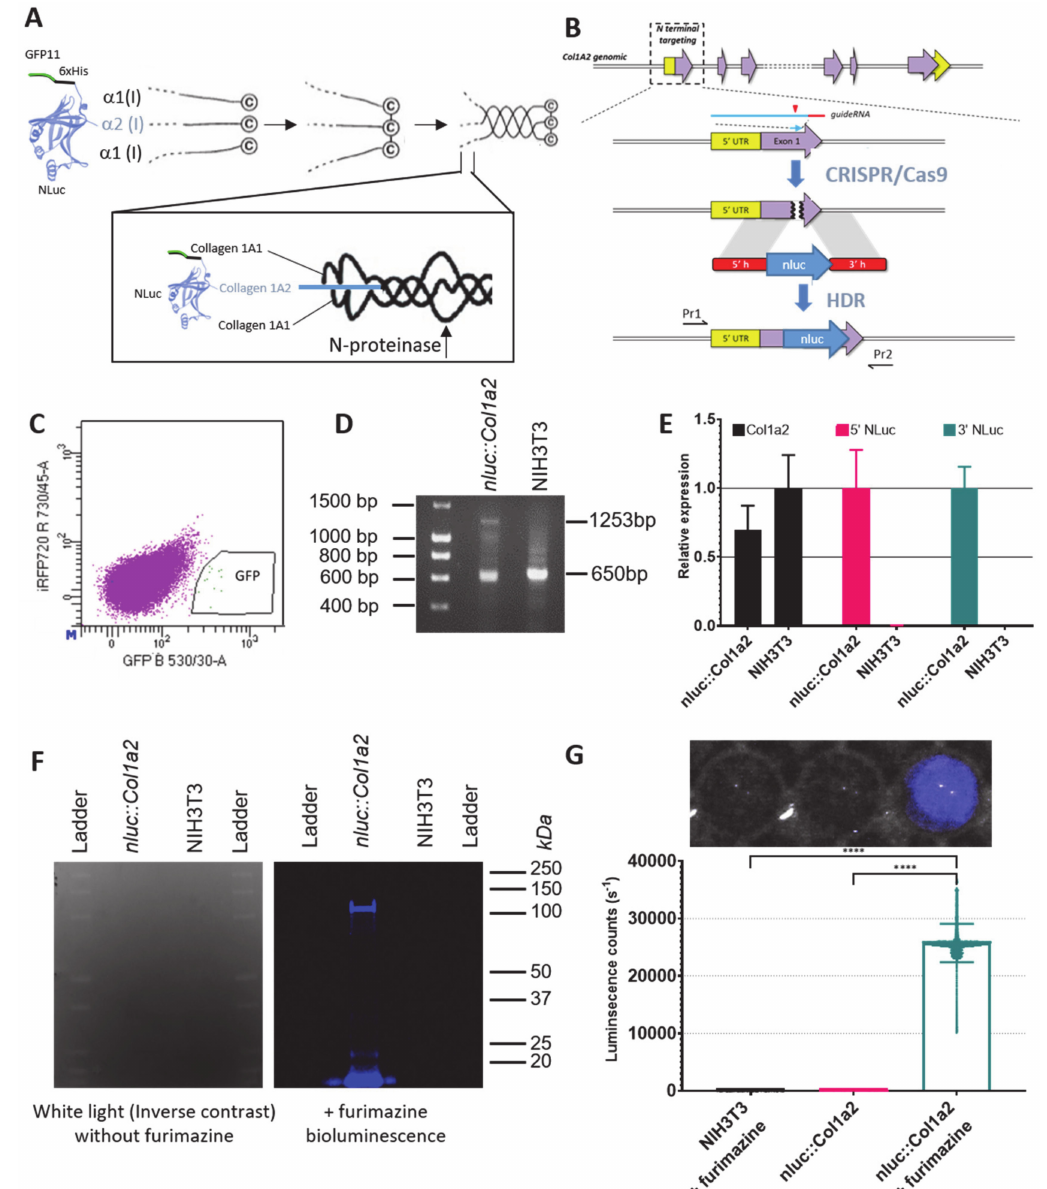
Figure 1. Quantitative CRISPR / Cas9 editing strategy. ( A , B ) Tagging strategy to allow quantitation of PC-I in NIH3T3 fibroblasts with the introduction of a multifunctional tag at the N-terminus of pro α 2(I) to allow detection of edited cells, and the small luciferase, NLuc. Schematic not drawn to scale. The estimated molecular weights of each domain are: GFP11 (residues 215-230; 1773 Da), 6xHis (840 Da), NLuc (19095 Da). ( C ) After introduction of the multifunctional tag in exon 1 of Col1a2 using CRISPR / Cas9, edited cells were sorted based on GFP fluorescence. ( D ) PCR validation of edited DNA in cells isolated from ( C ) using primers in Table S1. ( E ) Real-time PCR of total Col1a2 transcripts (Black) and edited transcripts in NIH3T3 and nluc::Col1a2 cells. Primers at the 5 (cid:48) and 3 (cid:48) ends of the introduced nluc confirmed insertion into the Col1a2 transcript. Bars show mean ± SD, n = three independent experiments. ( F ) In-gel detection of NLuc tagged pro α 2(I) chain under reducing conditions identified NLuc activity at approximately 140 kDa. ( G ) Imaging and quantitation of the light produced by nluc::Col1a2 and unedited NIH3T3 cells incubated with the NLuc substrate, Furimazine (Nano-Glo). On a 96-well plate, single wells were imaged using a single-lens reflex camera and quantitation of photon counts was performed using a multiwell plate luminometer. Bar shows means ± SD from n = 30 replicate measurements. **** represents p = 0.0001, paired Student’s